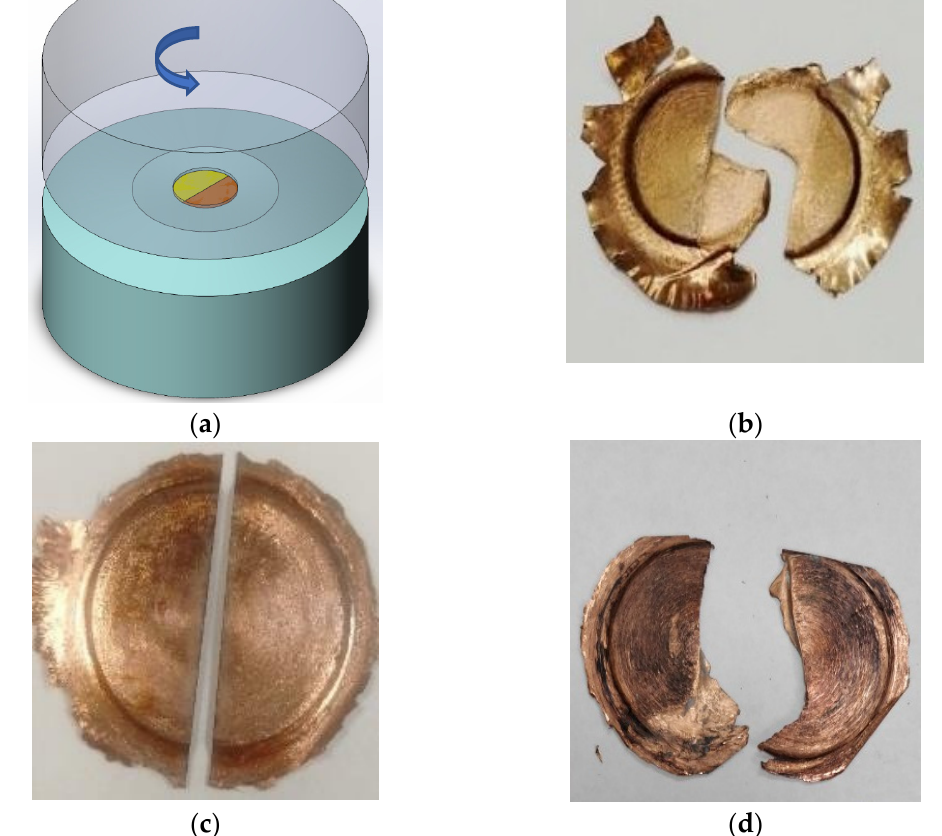
Figure 1. Schematic of joint HPT halves to determine the degree of shear strain ( a ), copper halves disc after joint HPT n = 1/4 ( b ), copper disk after HPT n = 5 cut into halves ( c ), same halves after subsequent joint HPT n = 1/4 ( d ).